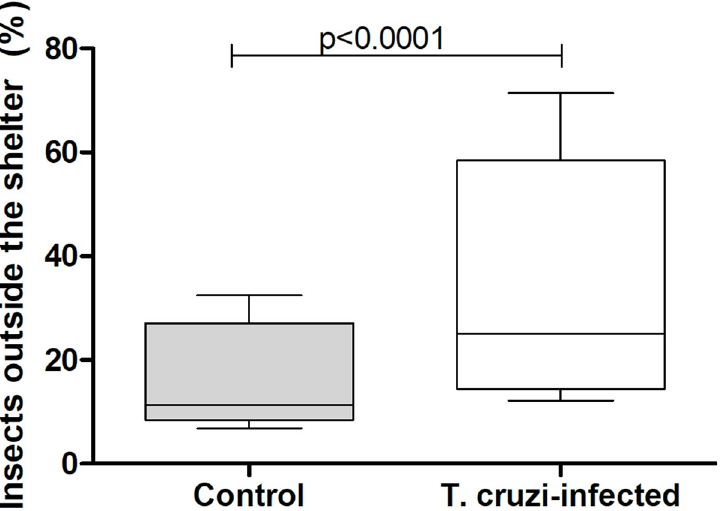
Fig 4. Percentage of Trypanosoma cruzi -infected and uninfected Rhodnius prolixus nymphs that remained outside the shelter three hours after the host had been removed from the arena. Data depicted represent the median (horizontal line) of the percentage of insects exposed outside shelters in five independent assays (25% - 75%, Max— Min).